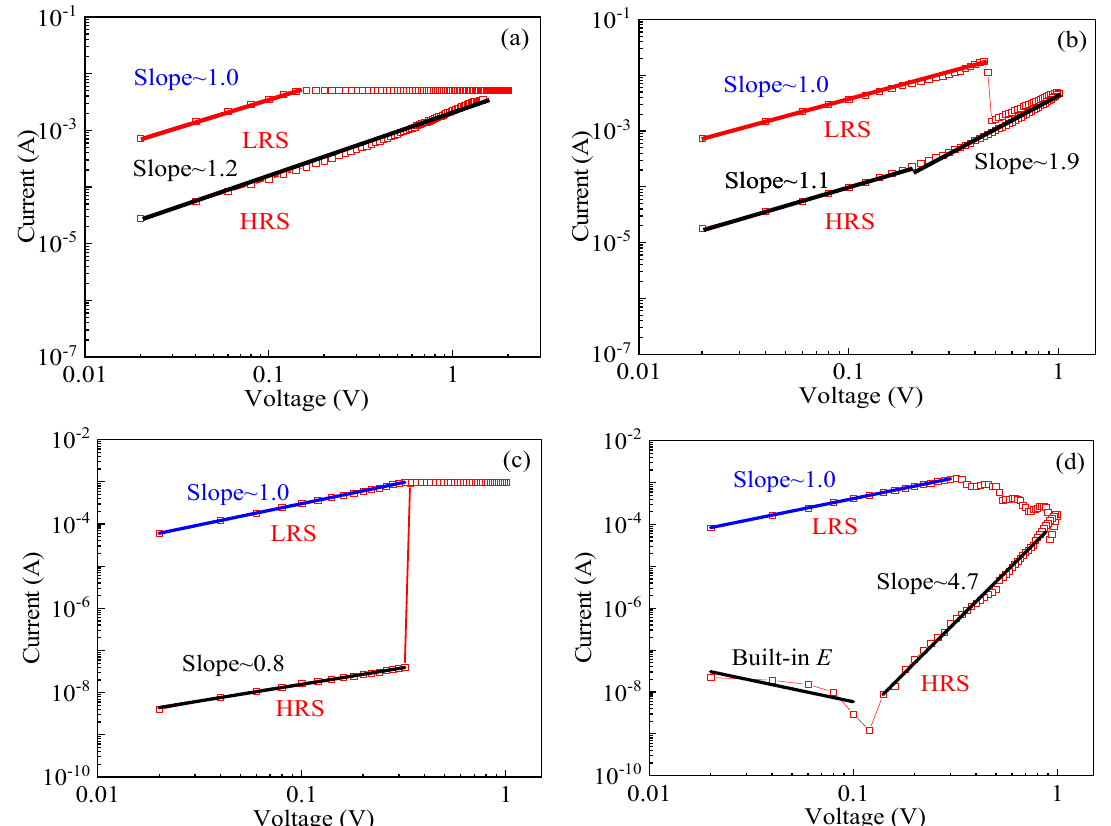
Figure 10. The linear fitting of the I–V curve of the LZO-0 and -5 devices in the double logarithmic scale: ( a ) in the positive bias region of LZO-0; ( b ) in the negative bias region LZO-0; ( c ) in the positive bias region of LZO-5; ( d ) in the negative bias region LZO-5. Micromachines 2020 , 11 , x